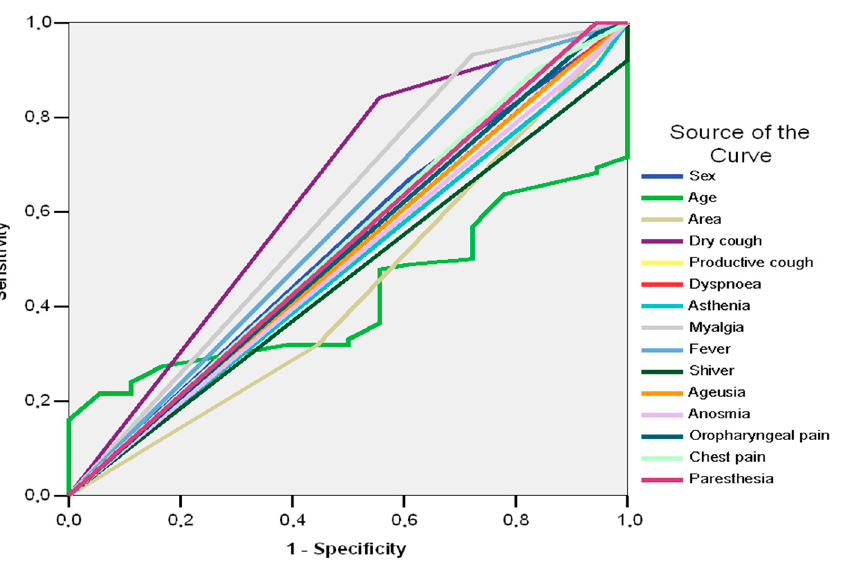
Figure 3. AUC. The sensitivity/specificity balance of demographical data, signs, and symptoms in the determination of unfavorable evolution in patients with SARS-CoV-2 and pneumonia.